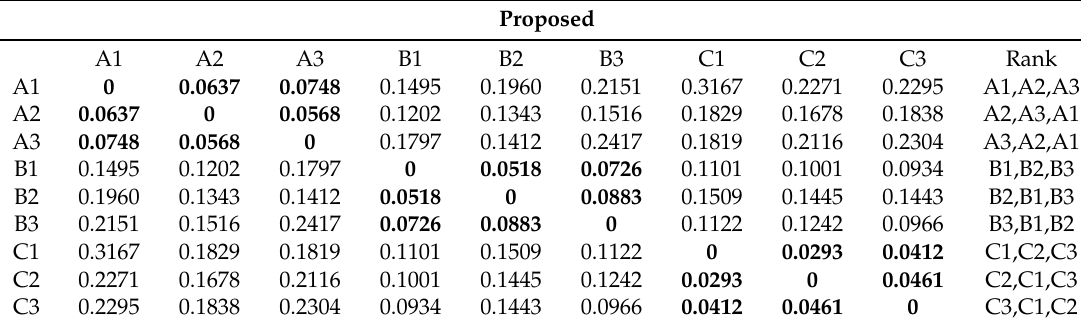
Table 6. The performance of the proposed index for the AVIRIS dataset.